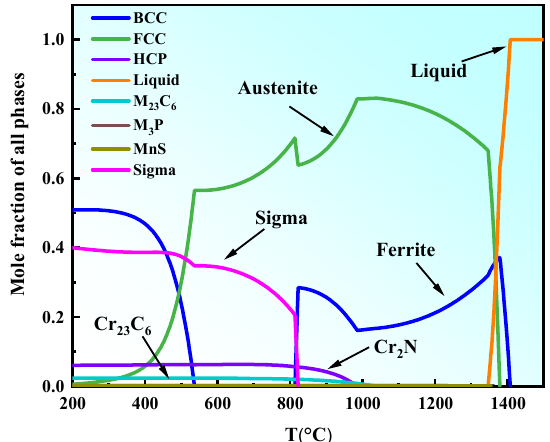
Figure 1. Equilibrium fraction plot for each phase of HNS versus